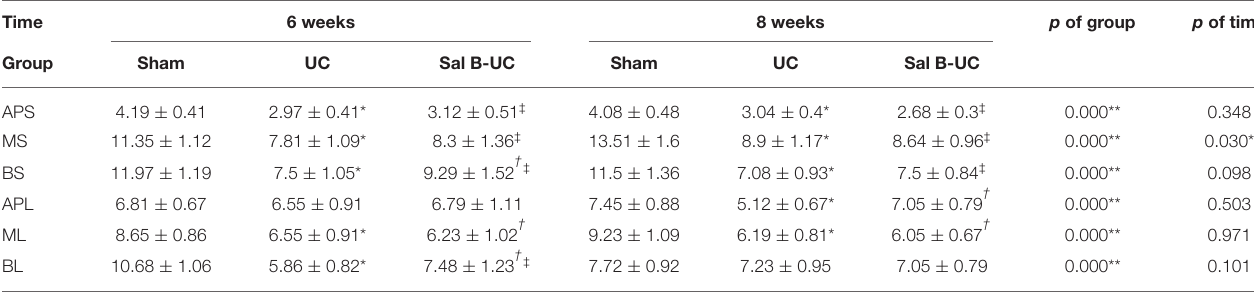
TABLE 3 | 2D-speckle tracking echocardiography measurements in rats at 6 and 8 weeks. Time 6 weeks 8 weeks p of group p of time Group